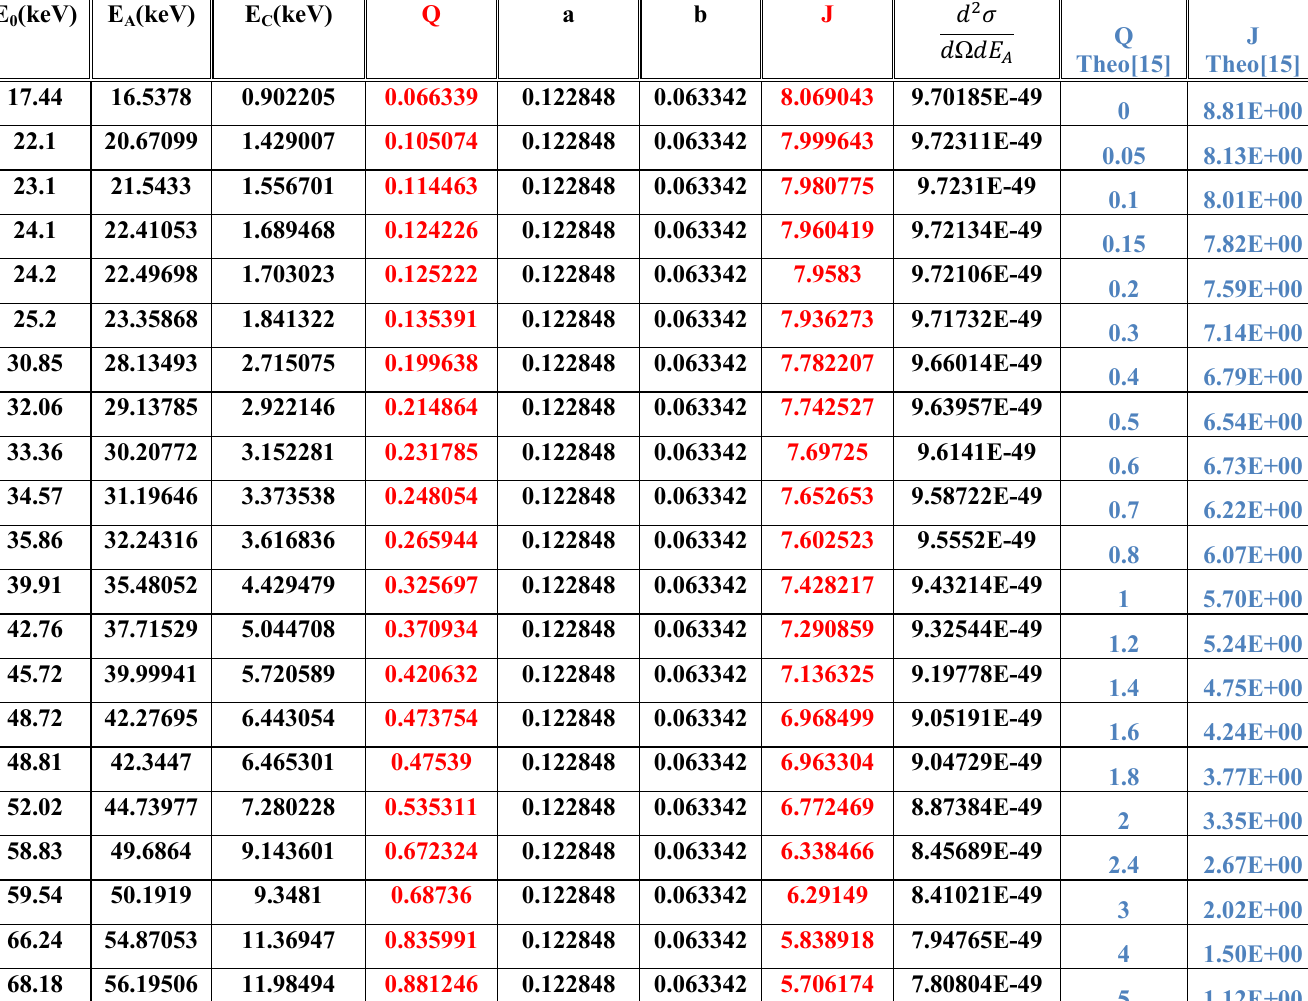
Table 3: Compton profile and double-differential cross section of doppler broadening for ( 47